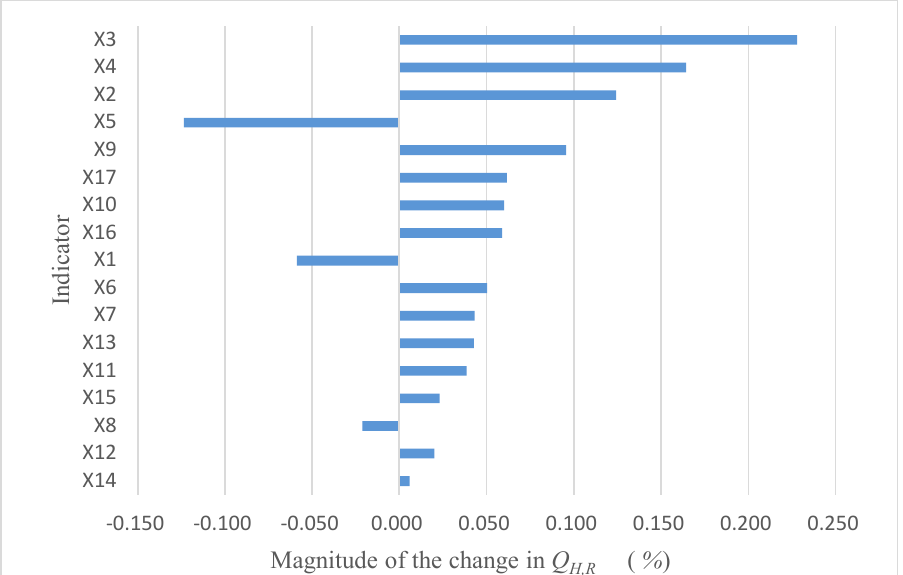
Fig. 3 Tornado diagram showing the sensitivity of Q H,R to a 1% increase in each of the 17 individual socioeconomic activity indicators considered in this work. influential factor with a negative impact on Q H,R was X 5 . Six indicators ( X 9 , X 17 , X 10 , X 16 , X 1 ) had modest impacts, causing Q H,R to change by 0.05–0.1%. The other indicators all changed Q H,R by less than 0.05%. The indicators associated with the most pronounced changes in Q H,R were all linked